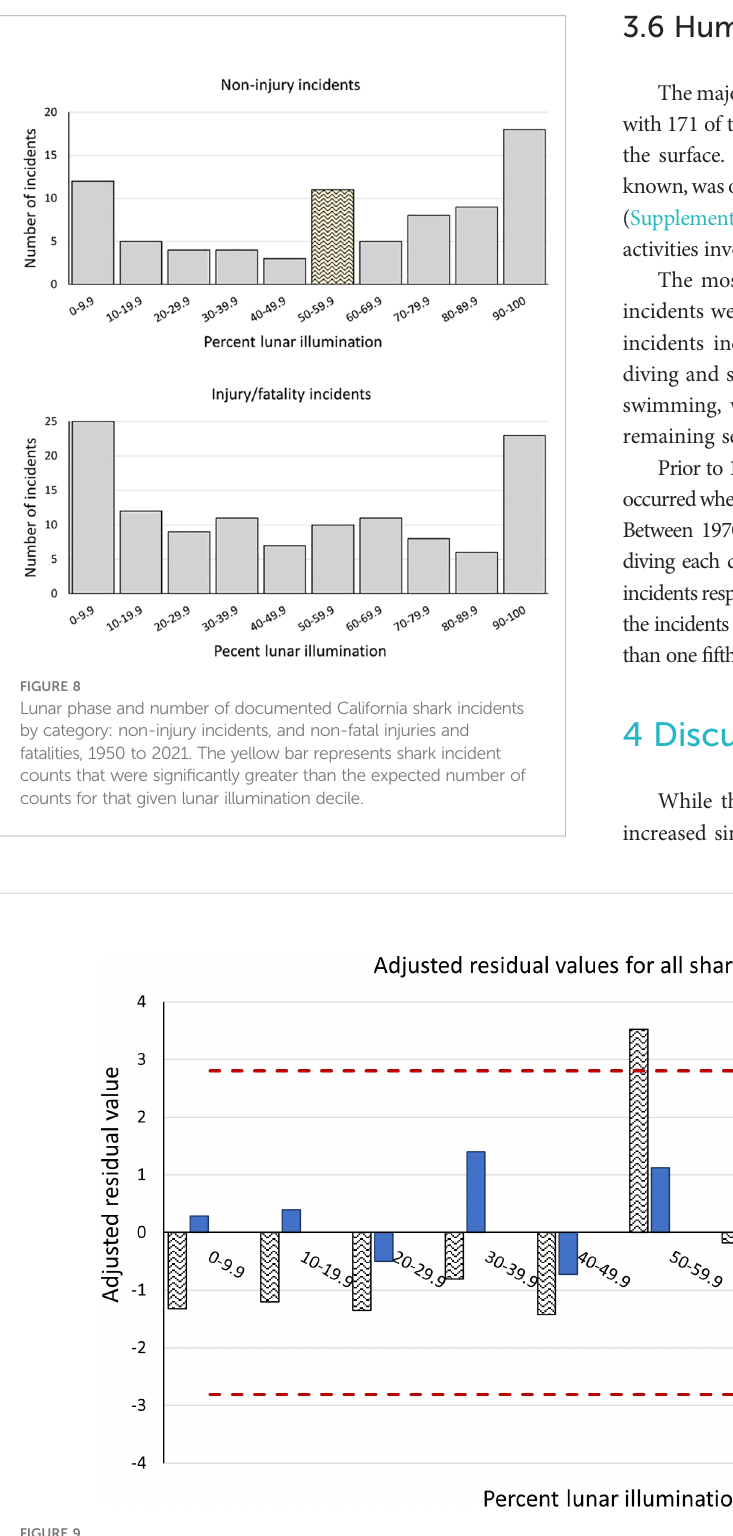
FIGURE 9 Adjusted residual values showing the direction and magnitude of difference between expected and documented number of shark incidents for all species by lunar illumination deciles, split by no injury and injury/fatality. The horizontal dashed red lines represent the cutoff for 95% signi fi cance. Bars that do not extend past the red horizontal dashed lines represent values that did not statistically differ from the expected count when analyzed with a Chi-squared test. Injury categories were tested separately but are presented together.